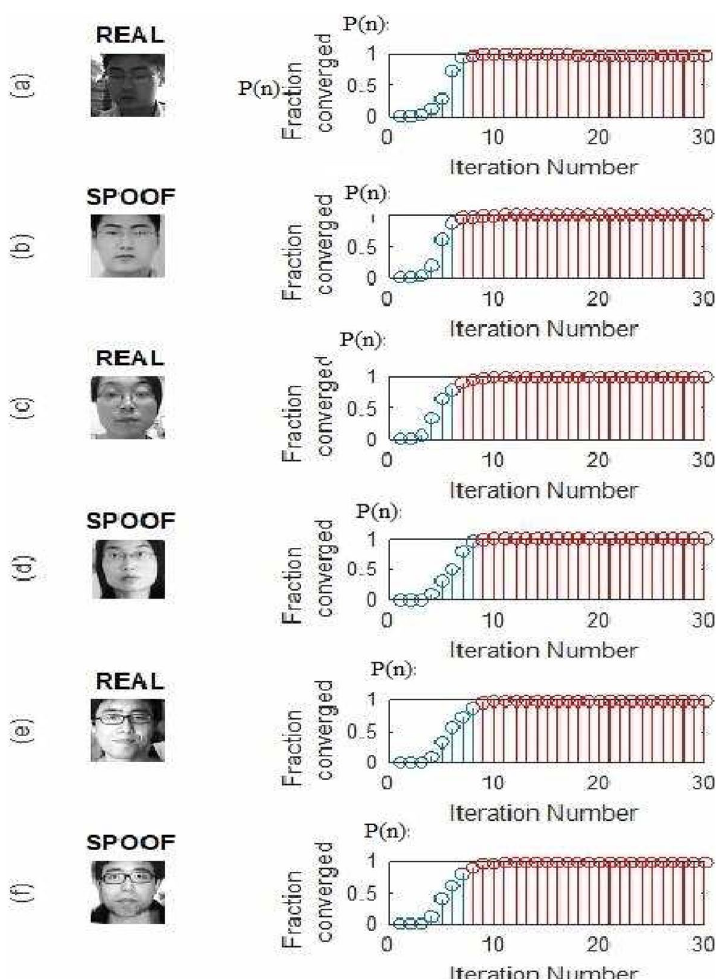
Fig. 8 Saturation curves which bring out the trends linked to the rate at which the initial image samples (either natural or spoof) converge to a zero-contrast image in the life